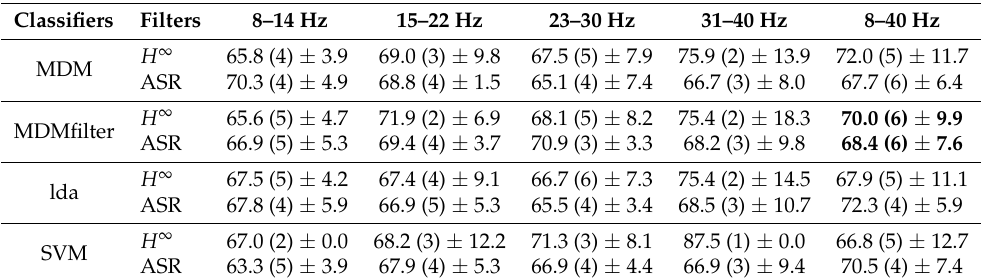
Table 3. Table with the average number of valid solutions per subject, depending on the classifier, artifact filter and frequency band. Filter settings with highest accuracy and value are highlighted in